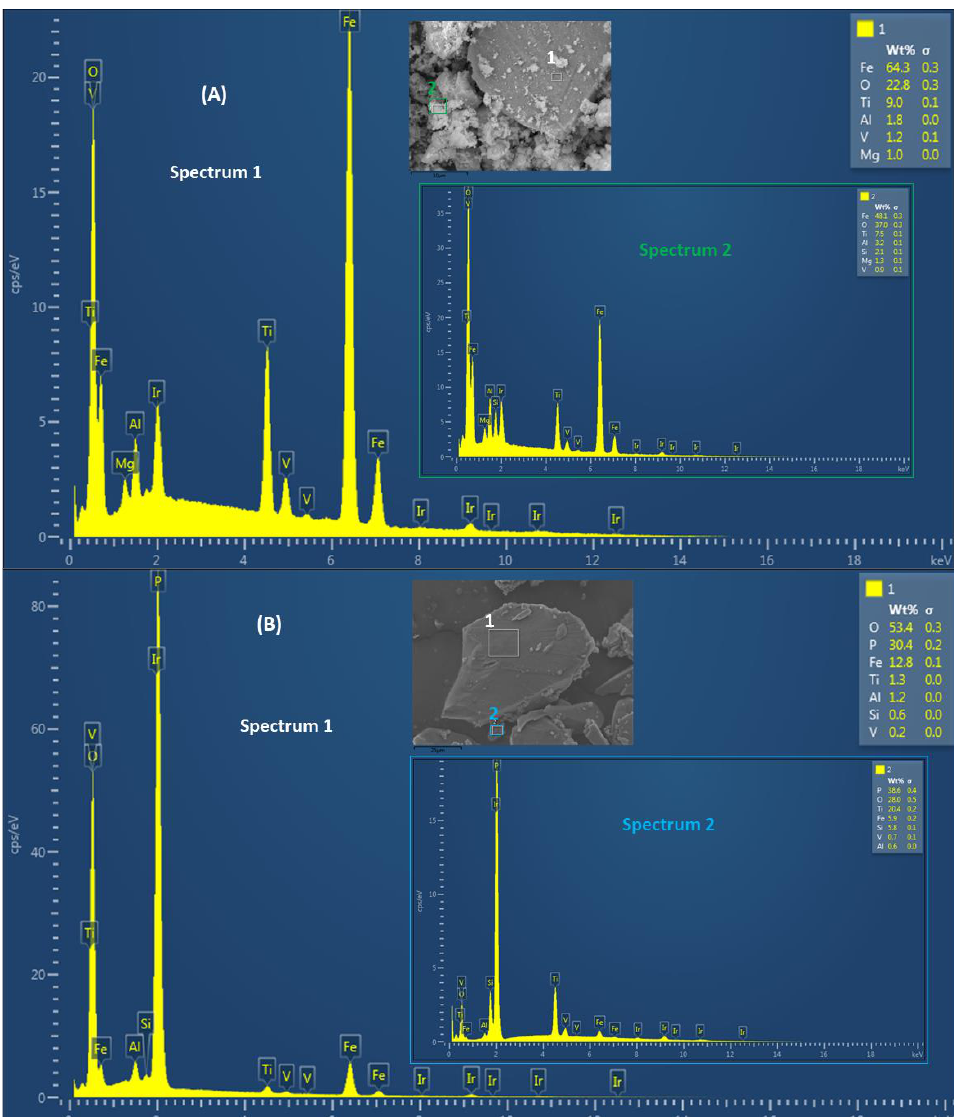
Figure 3. SEM-EDX graphical images and elemental results of ( A ) the original AMIS 0501 mineral ore sample and ( B ) precipitate isolated using ammonium phosphate flux. ore sample and ( B ) precipitate isolated using ammonium phosphate